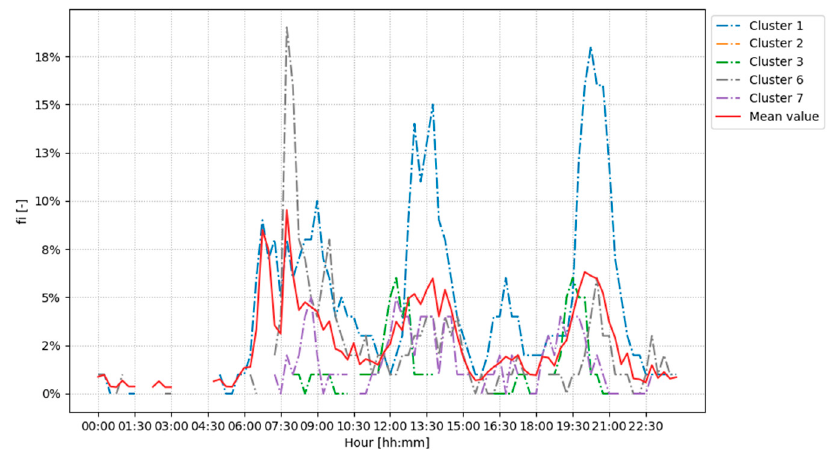
Buildings 2020 , 10 , x FOR PEER REVIEW Figure 12. Daily usage probability: Microwaves. Figure 12. Daily usage probability: Microwaves.